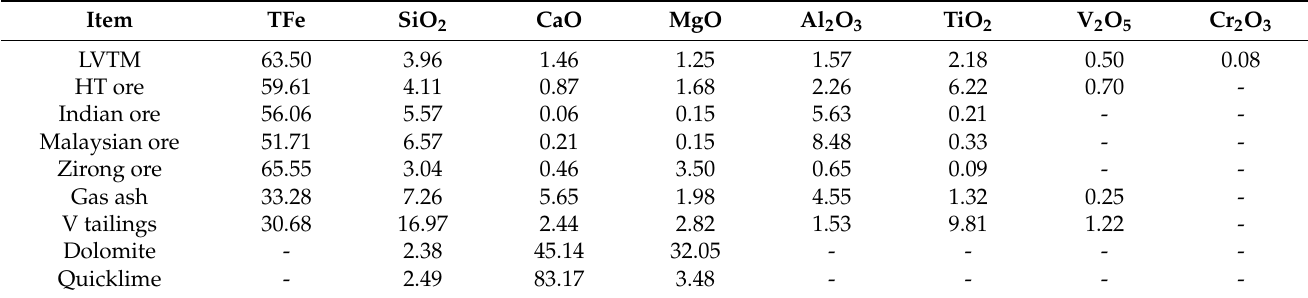
Table 1. Chemical compositions of the raw materials (wt, %).